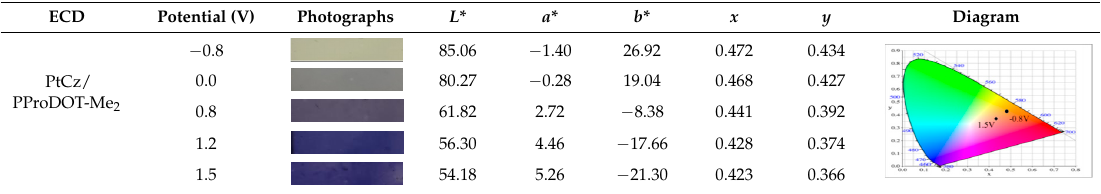
Diagram Diagram Diagram